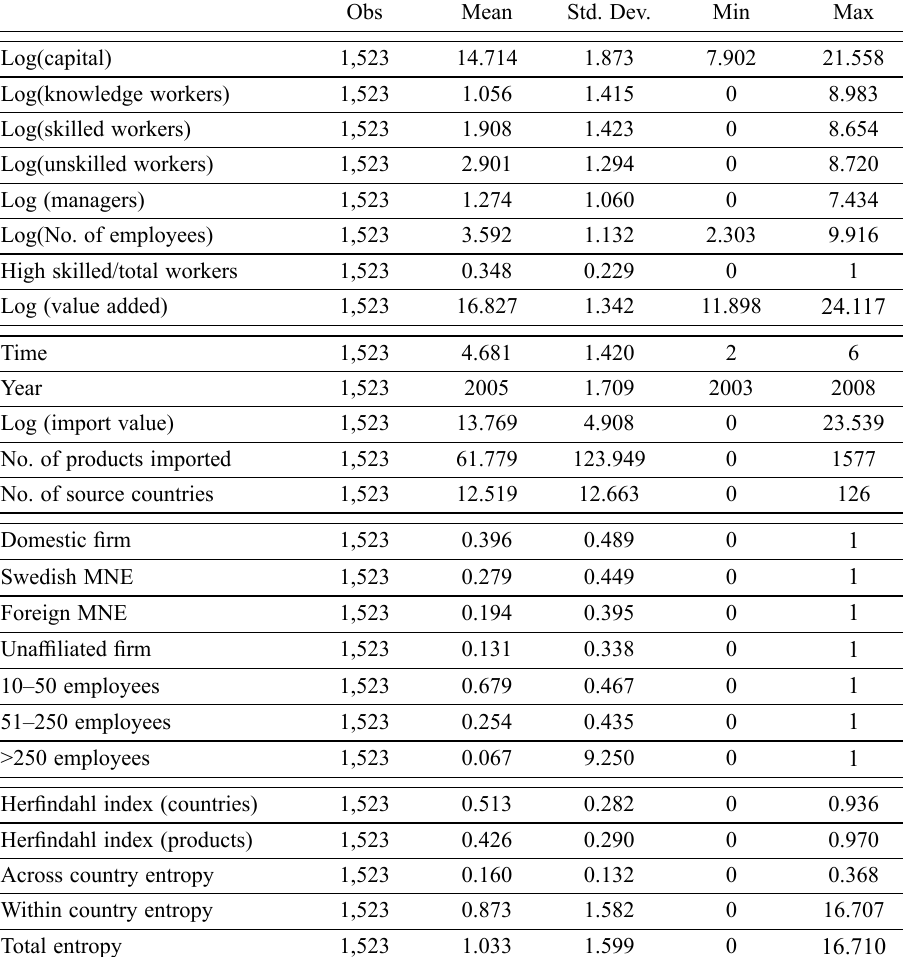
Table 1. Descriptive statistics for sample of ICT manufacturing firms with 10 or more employees Obs Mean Std.